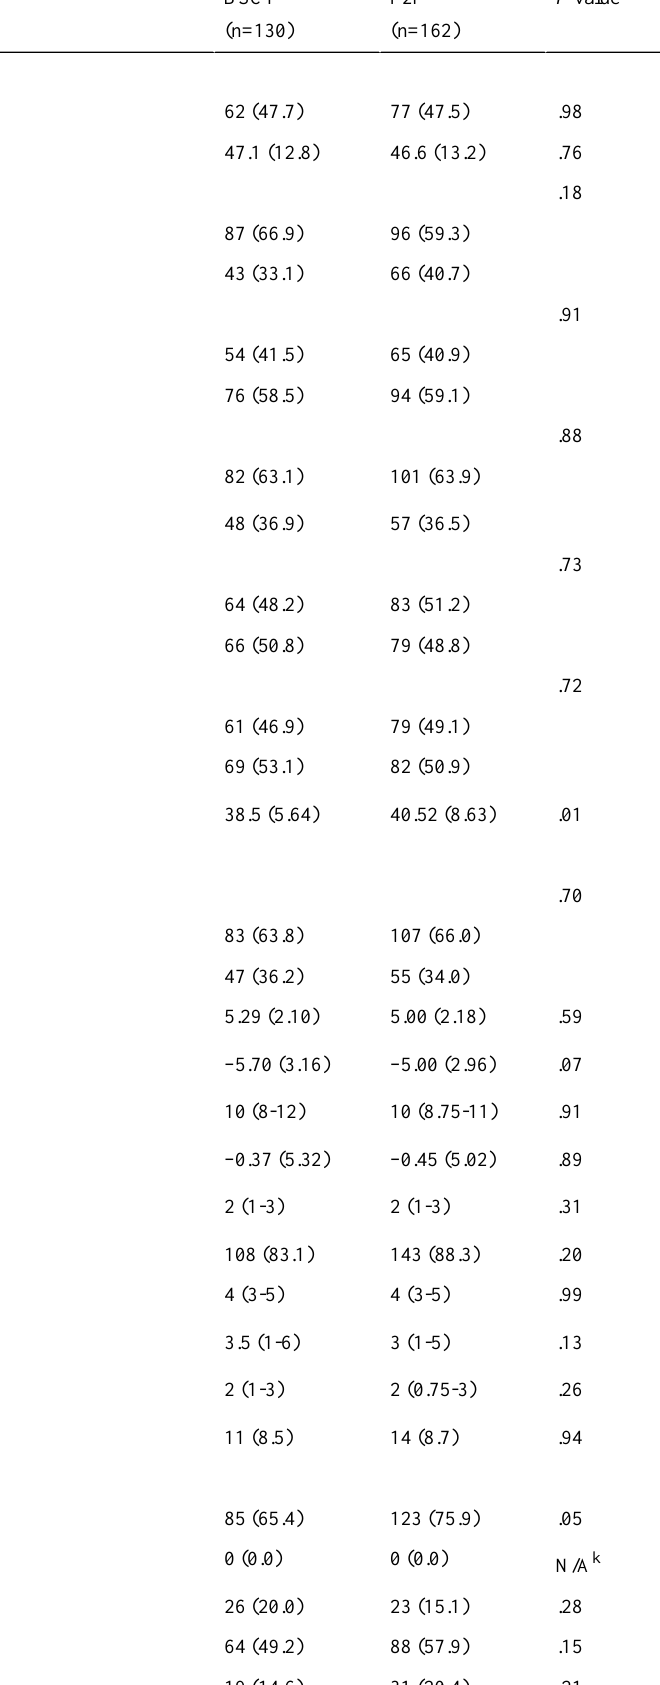
Table 3. Patients’characteristics of both the blended smoking cessation treatment (BSCT) and face-to-face (F2F)